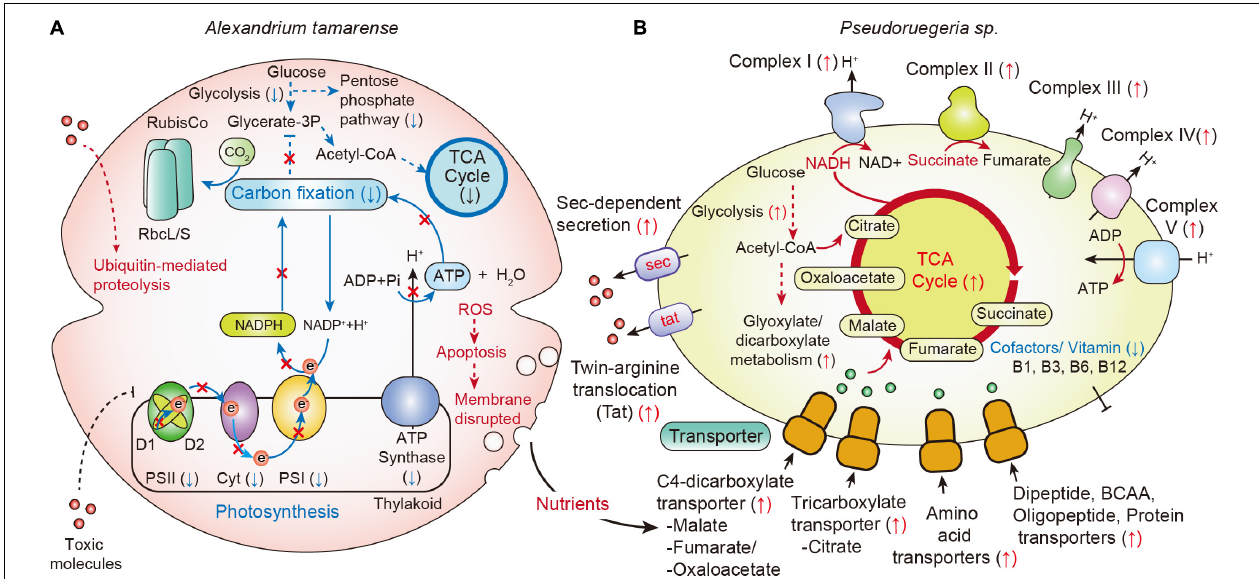
FIGURE 6 | Changes in metabolic pathways by communication between A. catenella and Pseudoruegeria sp. (A,B) A scheme for the communication of A. catenella (A) and Pseudoruegeria sp. (B) during co-culture is displayed based on transcriptome analysis. Blue and red arrows indicate the downregulated ( ↓ ) and upregulated ( ↑ ) genes, respectively. The dashed line indicates multiple reaction